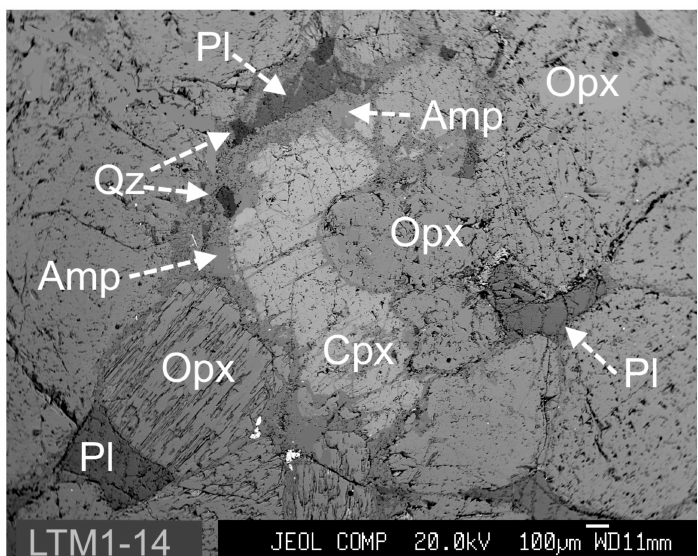
Figure 8. A BSE image shows a corona-type texture in the orthopyroxenite zone of the Lotmvara-I sill. It is represented by the development of a partial rim of clinopyroxene (Cpx) around a core grain of orthopyroxene (Opx). The Cpx shell itself is surrounded partially by a composite rim of amphibole (Amp), plagioclase (Pl), and quartz (Qz). The location of this sample, Ltm1-14 (Figure 6b), is shown in Figure